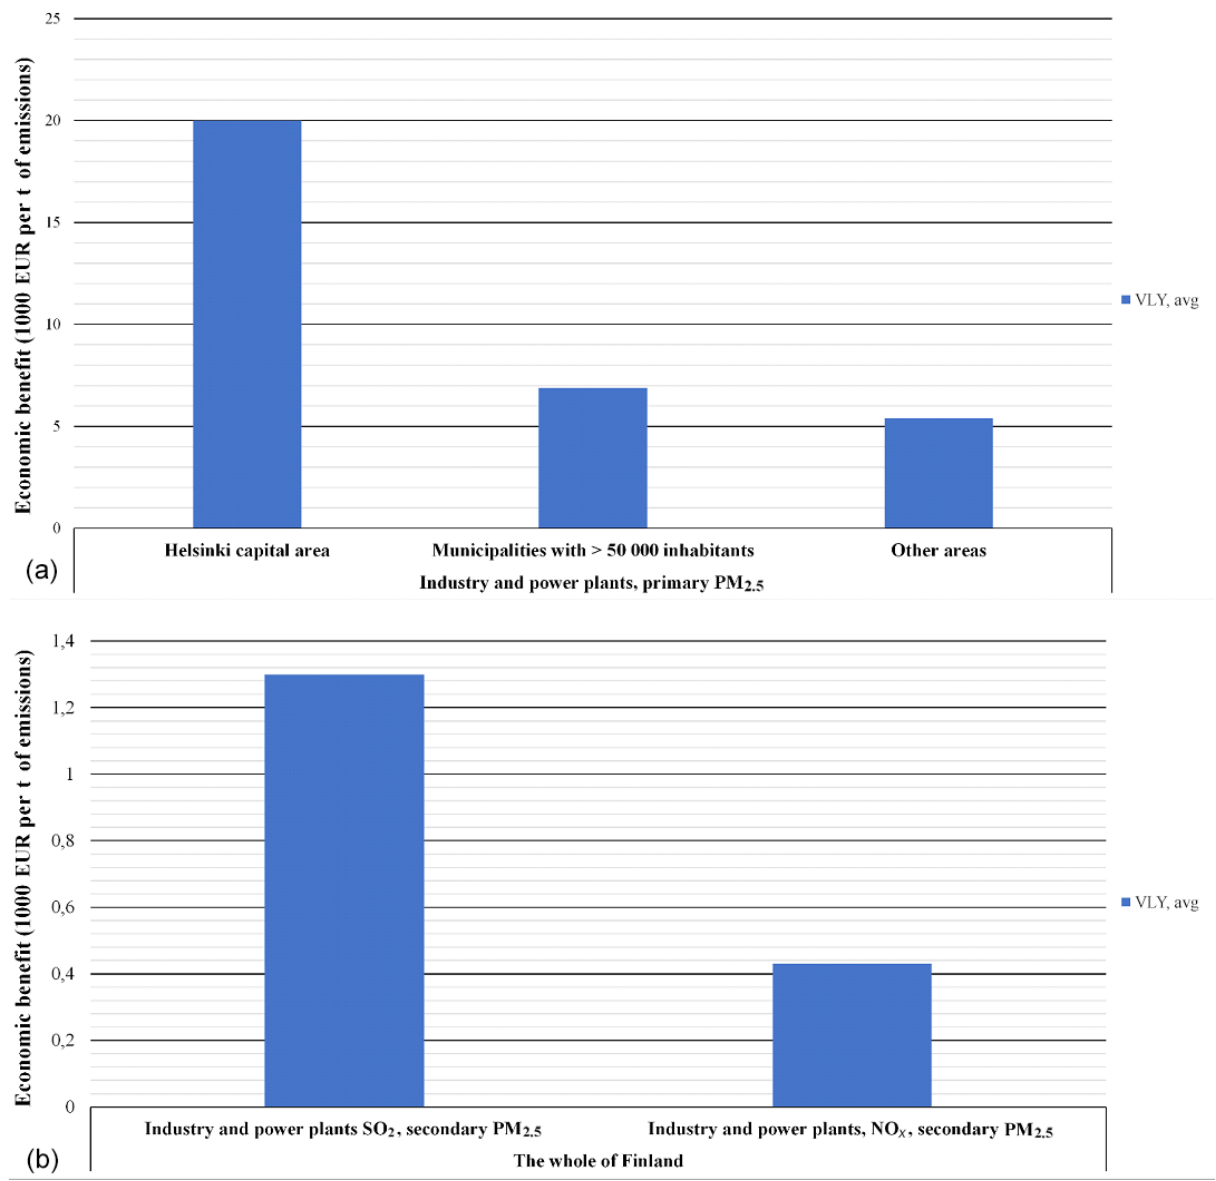
Figure 6. Economic benefits obtained from the assumed reductions in emissions, in 1000 EUR per tonne of emissions, for sources having a high emission height. These results are presented for industry and power plants. (a) Results for the emission reductions in PM 2 . 5 for various geographic regions and (b) for the emission reductions in SO 2 and NO x for the whole of Finland. All the values correspond to the computations using the average value of life year